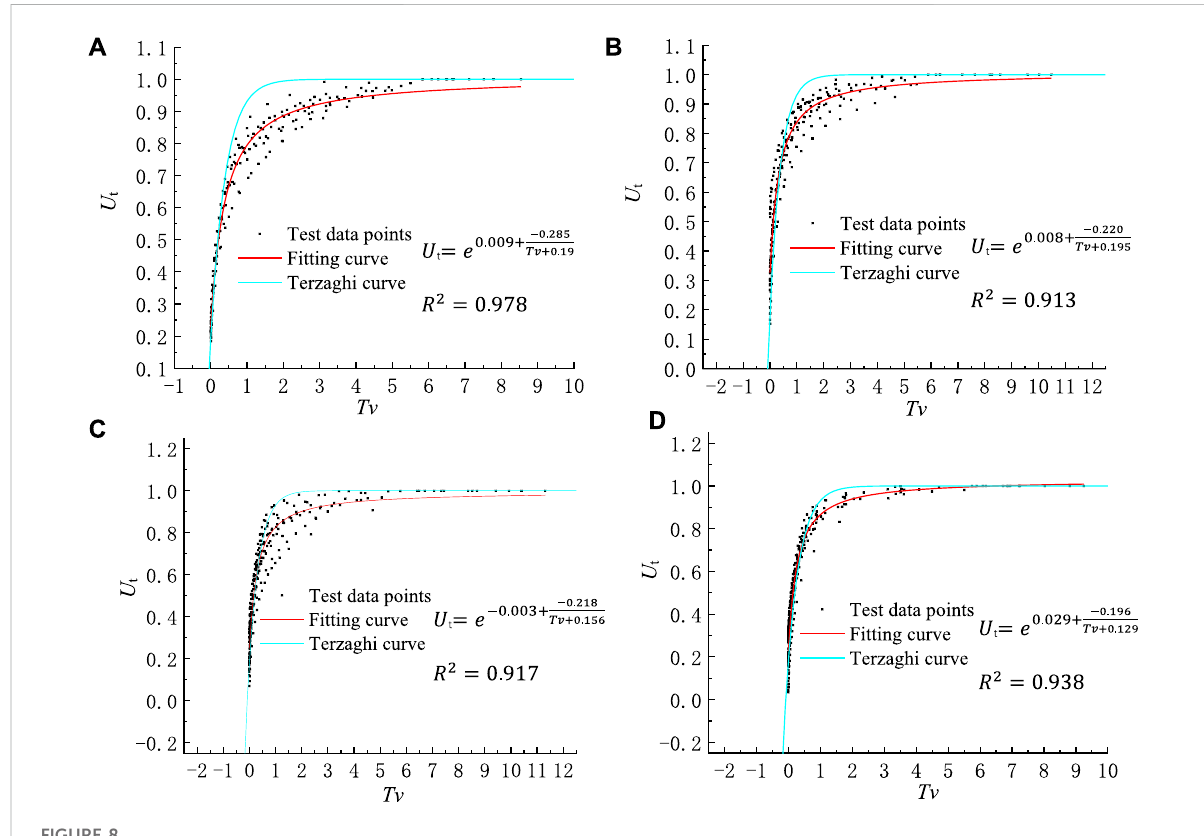
FIGURE 8 Data fi tting of U t - T v curves for the clayey soil samples at depth of 200 – 300 m under loads of 1.28 MPa (A) , 2.56 MPa (B) , 5.12 MPa (C) and 10.24 MPa (D) .